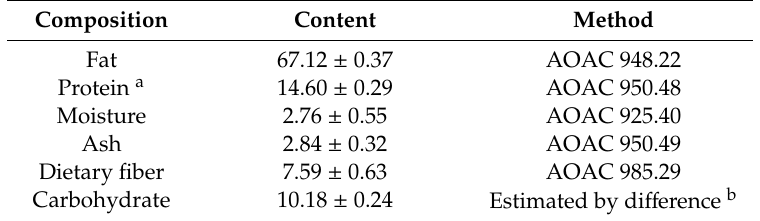
Table 1. Chemical compositions (g / 100 g, average ± SD of three replicates) of the pecan